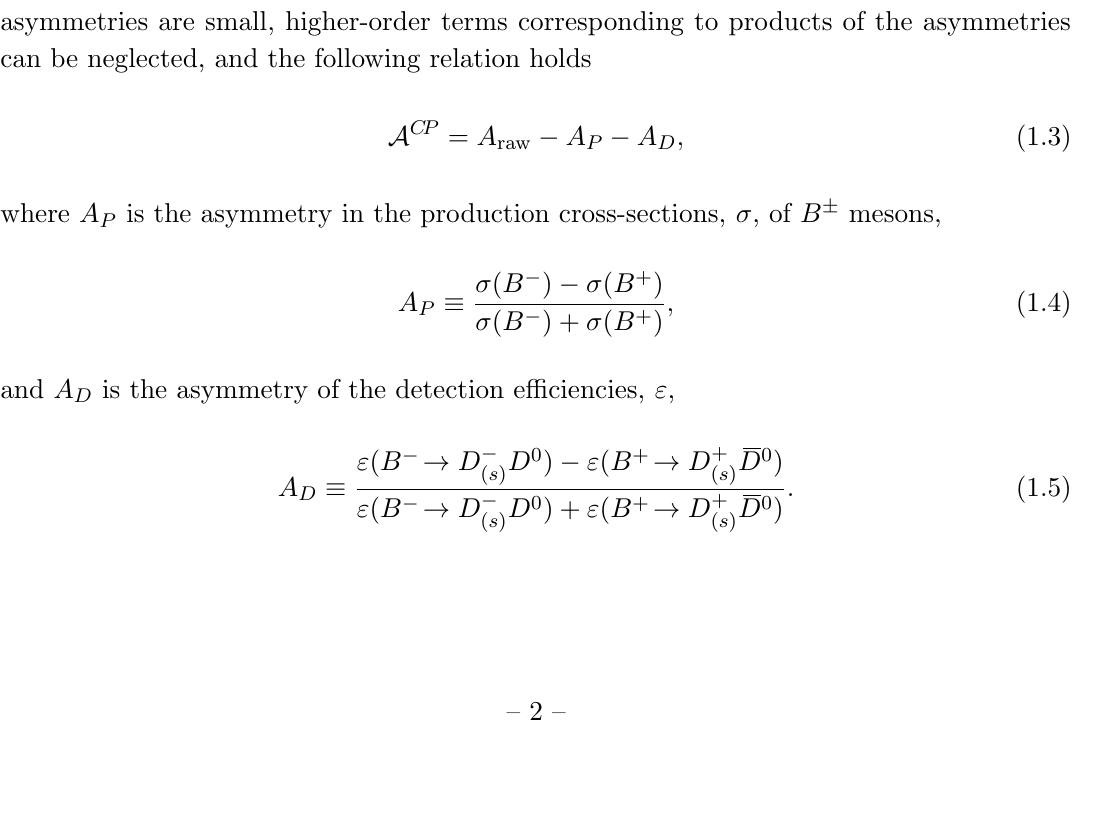
D 0 . s D 0 and s p s = 7